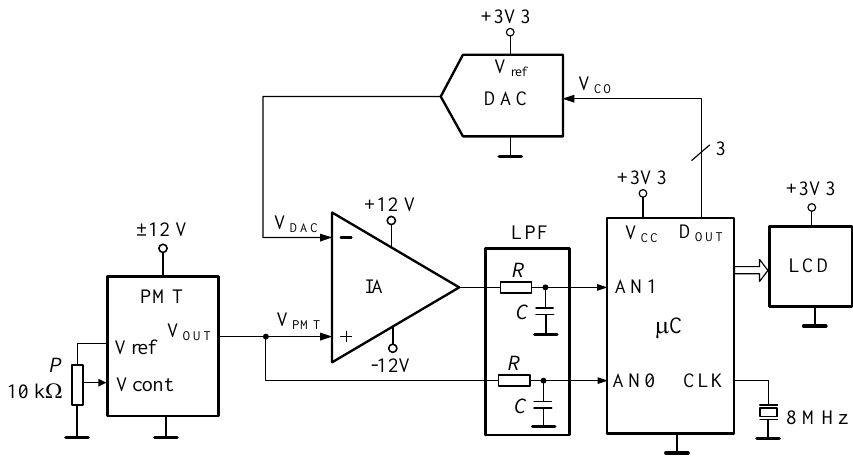
Figure 4. Simplified electronic schematic of the fluorimeter circuit (IA—instrumental amplifier, PMT—photomultiplier, DAC—digital to analog converter, LPF—low-pass filter, µ